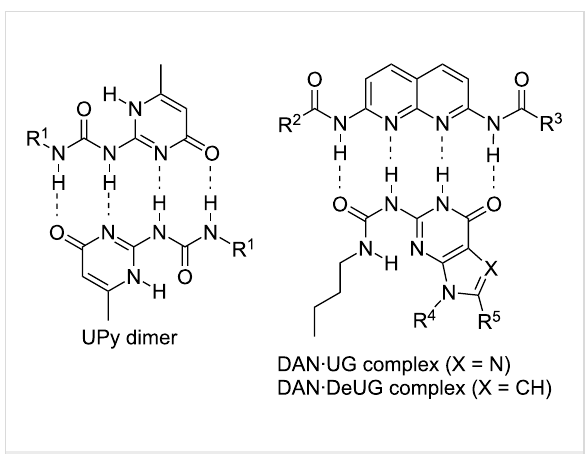
Figure 1: Chemical structures of UPy dimer and DAN complexes with UG and DeUG.